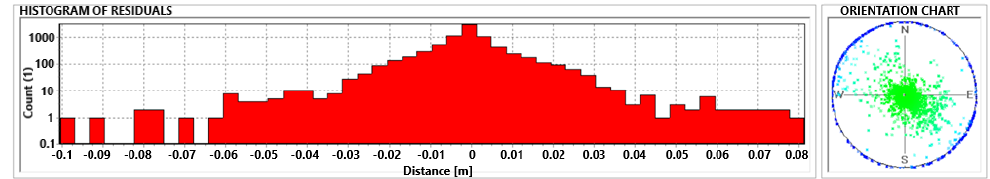
Figure 5. Histogram of residuals and orientation chart of the bore-sight calibration result show good accuracy and reliability of the solution.